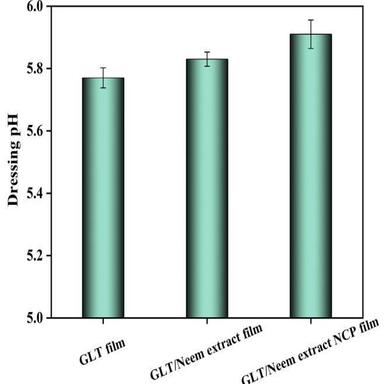
Dressing pH of GLT film, GLT/Neem extract film, and GLT/Neem extract NCP film.